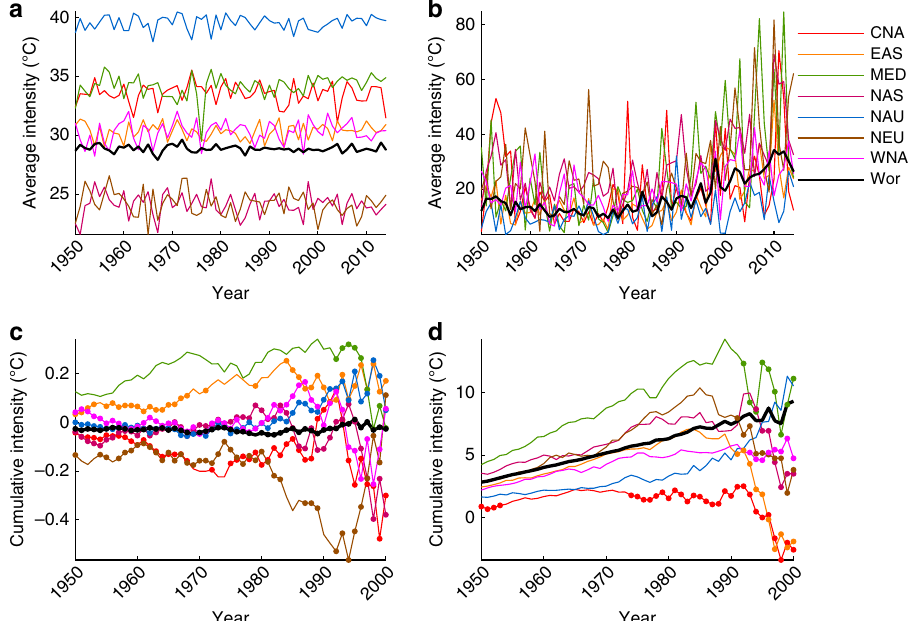
Fig. 4 Heatwave regional and global timeseries. Selected timeseries of average heatwave intensity ( a ); and cumulative heat ( b ). Decadal trends in average heatwave intensity ( c ); and cumulative heat ( d ) commencing yearly between 1950 and 2000 and truncating in 2017. All values are calculated for the global observational dataset Berkeley Earth (see “ Methods ” ). Closed circles in ( c ) and ( d ) indicate when trends commencing in that year are NOT statistically signi fi cant at the 5% level (see “ Methods ” ). Regions displayed are Central North America (CNA), East Asia (EAS), Mediterranean